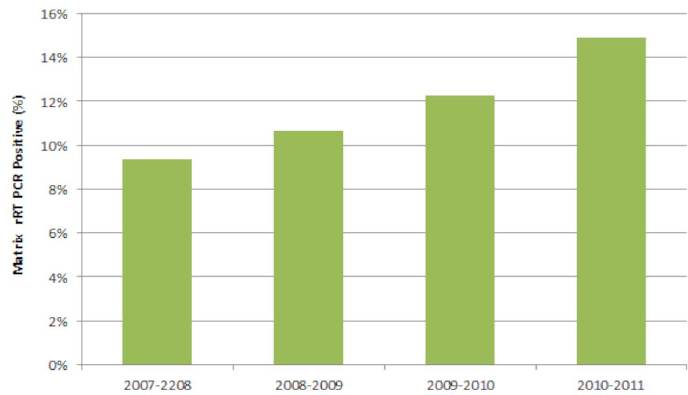
Figure 5. Influenza virus M gene rRT-PCR positive wild bird samples. Average prevalence and sample size are plotted by year.